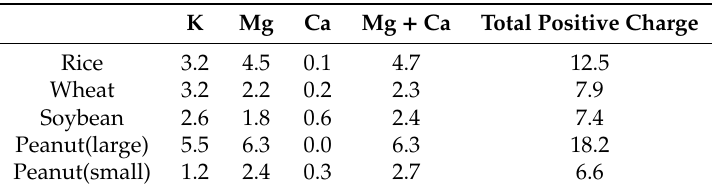
Table 2. Molar ratio of the major cations relative to phytate, and the sum of their charge relative to phytate. This was calculated from available data for purified globoids [27,30,40,41]. K